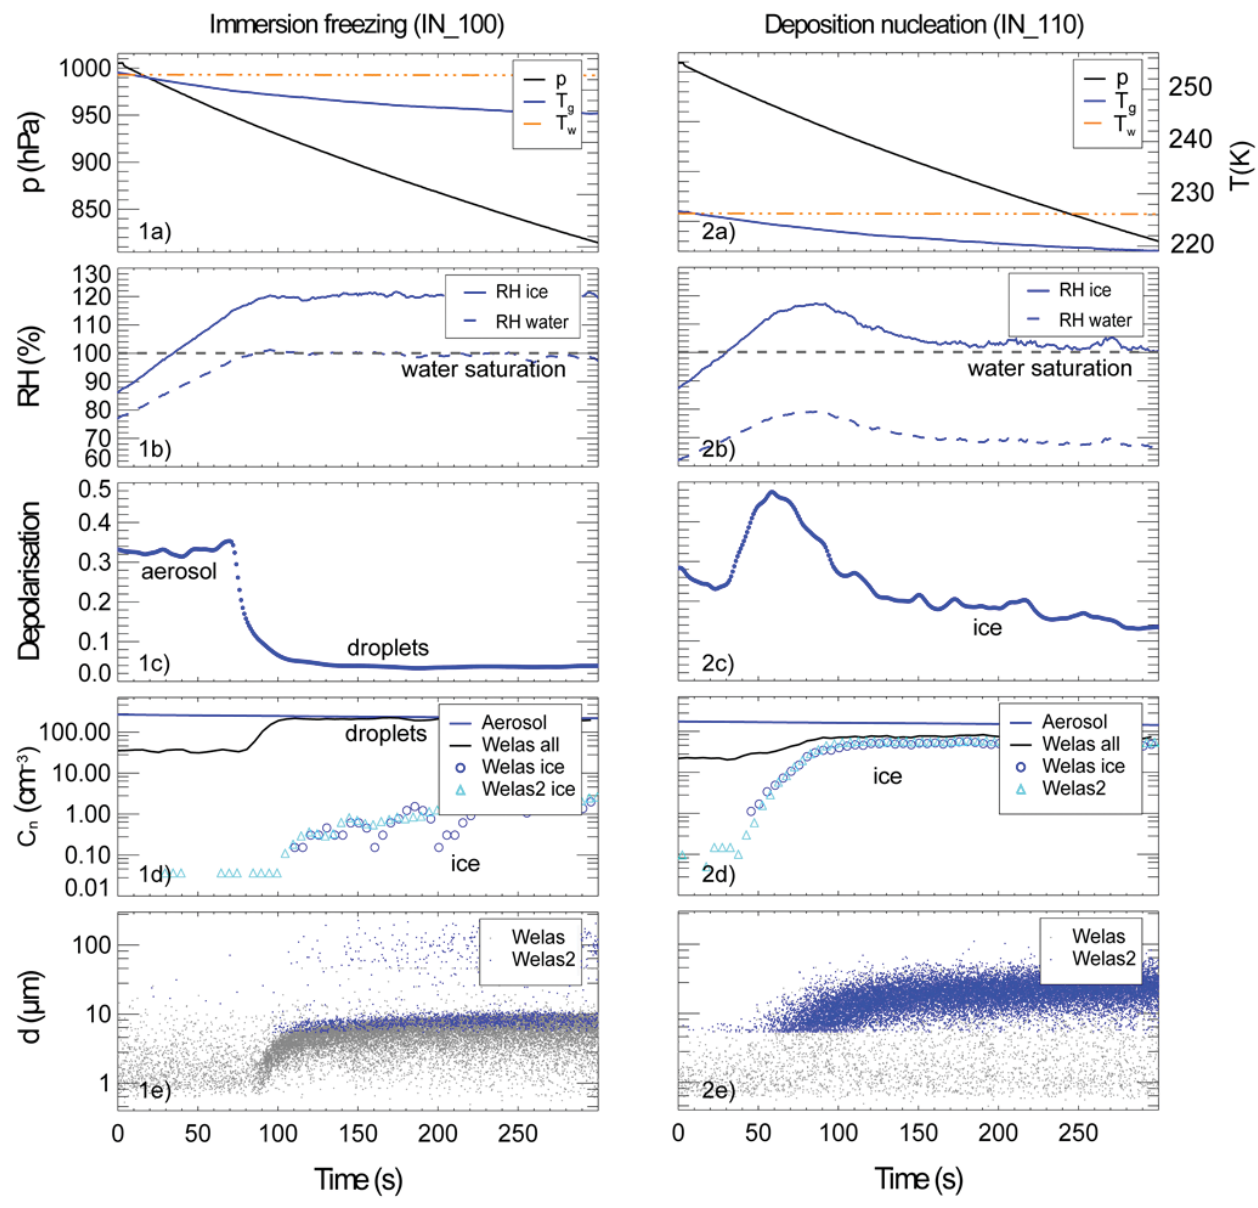
Fig. 2. Time series of two experiments showing immersion freezing (1a–1e) and deposition nucleation (2a–2e). (a) Variation of the ther- modynamical variables during expansion: decrease in gas temperature T g and pressure p ; temperature at the walls of the vessel T w stays approximately constant, (b) Development of relative humidity over water and over ice as derived from TDL data, (c) Depolarisation of the backwardly scattered light (SIMONE) as an indication for the dominance of either droplets or ice crystals, (d) Aerosol number con- centrations (CPC3010) compared to particle concentrations (WELAS/WELAS2); ice crystal number concentrations are calculated from WELAS/WELAS2 data, (e) Temporal evolution of particle sizes as measured by